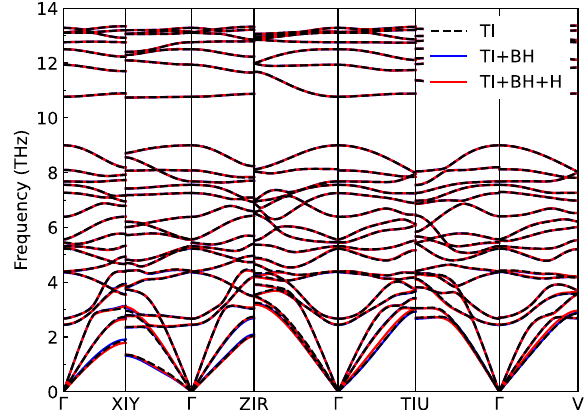
Fig. 1 Effects of the invariance conditions on the phonon dispersion of bulk silicon. TI denotes the correction of translational invariance on the IFCs, while BH and H represent the corrections by Born-Huang rotational invariance and Huang conditions, respectively.